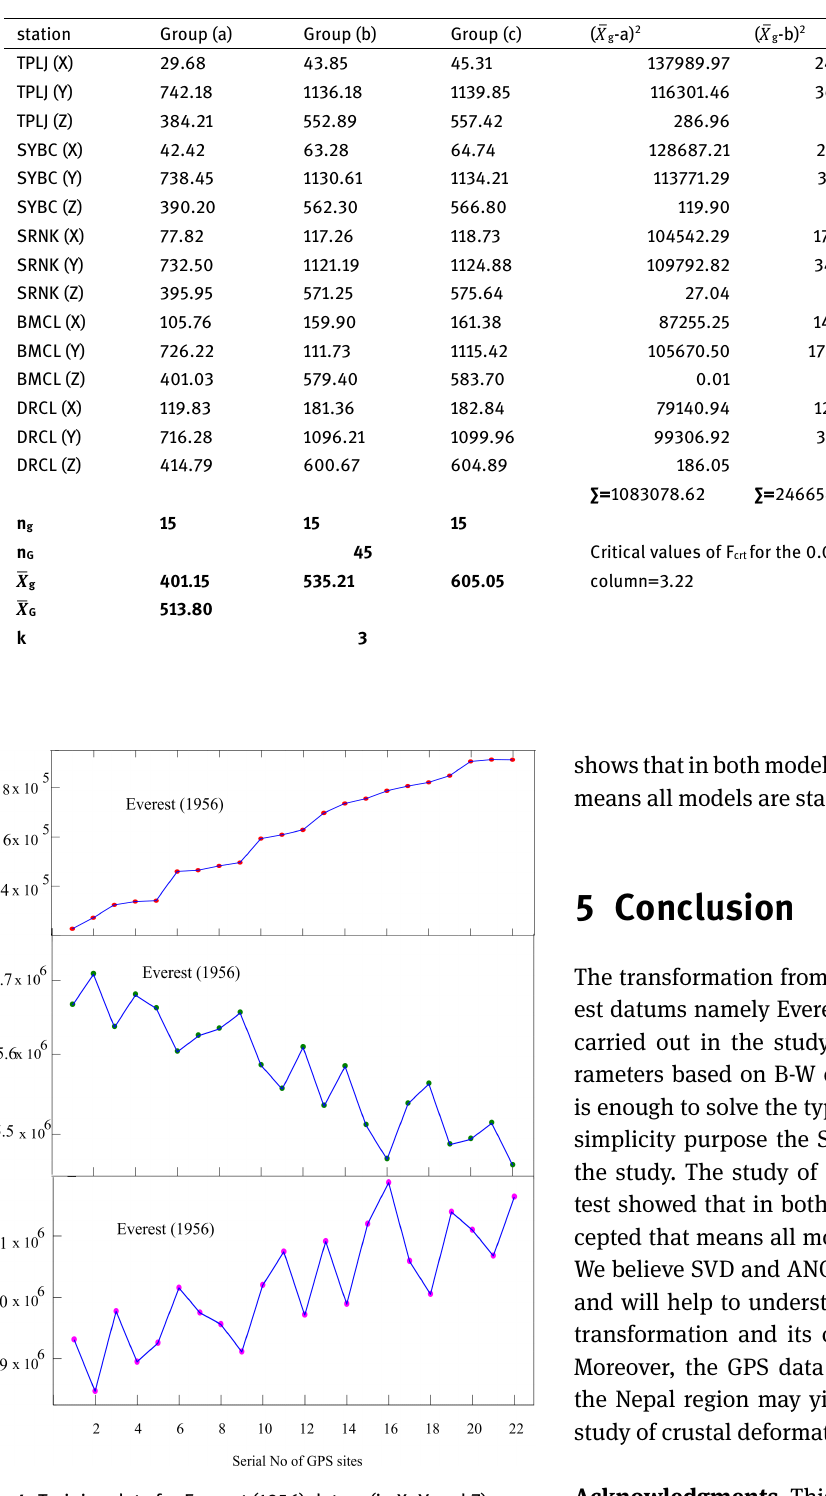
Figure 4: Training data for Everest (1956) datum (in X, Y and Z) coor- dinates and ANN prediction results